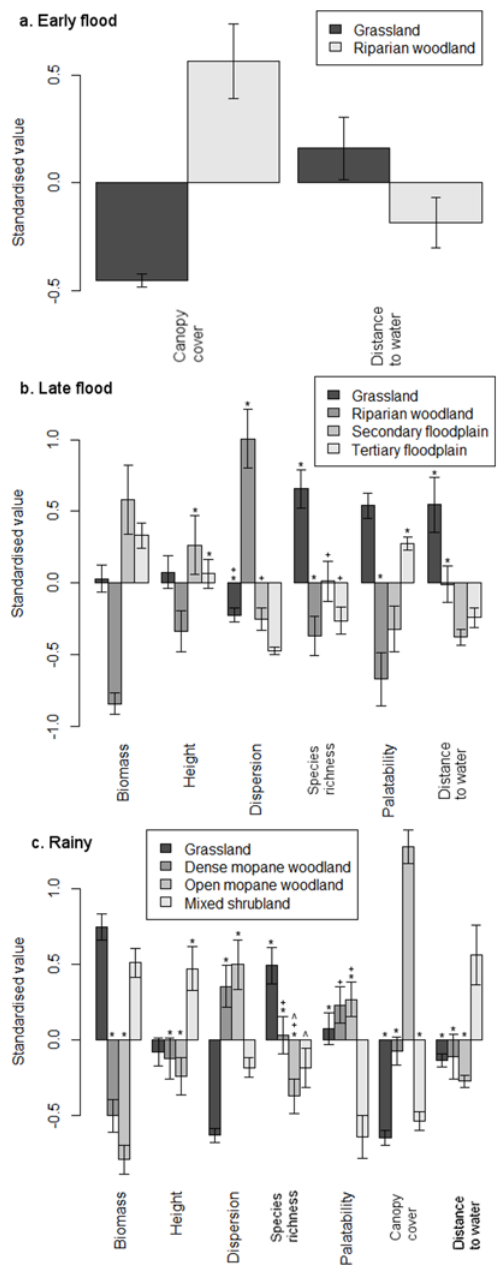
Fig 4. Variables discriminating between seasonally-preferred macrohabitats during the (a) early flood, (b) late flood and (c) rainy seasons. Values marked with ( * ), (+), or (^) were not significantly different from each